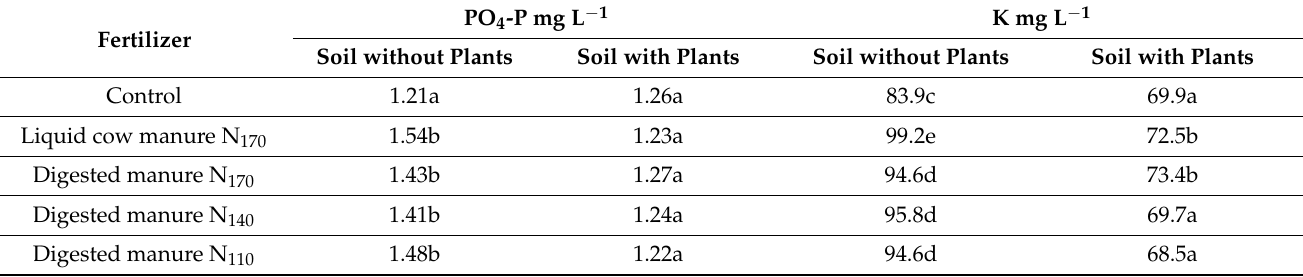
Table 4. The effect of digestate from liquid cow manure on the content of mobile phosphorus and potassium in soil